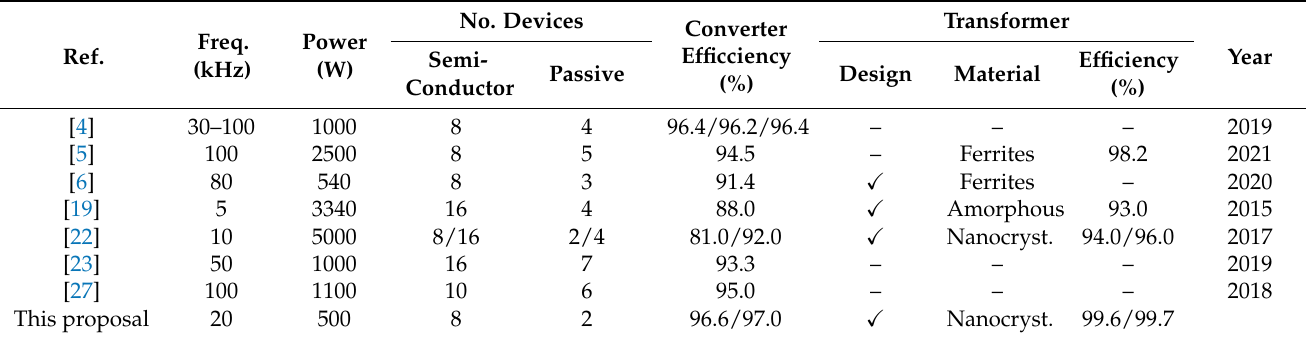
Table 4. Isolated DC-DC converters with high efficiency. Figure 14. Percentage of losses in the converter of ( a ) 2L and ( b ) 3L.